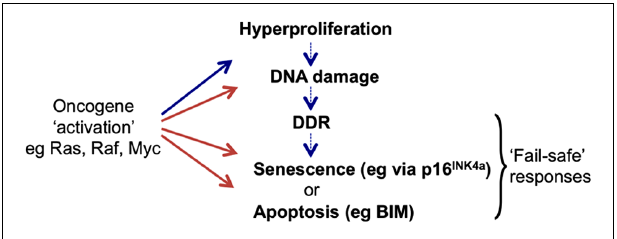
FIGURE 1 |Activation of cell proto-oncogenes can lead to oncogenic stress responses (OSR). Oncogene “activation” by mutation or constitutive expression at supra-physiological levels can induce aberrant cell division that may become manifest as rapid cell proliferation (hyperproliferation). However higher vertebrates have evolved cell intrinsic “fail-safe” responses to recognize such cells and so block their proliferation or eliminate them completely.These can include the induction of tumor suppressors (ts) such as p16 INK4a that halt the cell cycle and can cause cells to enter a prolonged state of arrest called senescence, or pro-apoptotic proteins such as BIM that can induce programmed cell death (apoptosis). Responses may involve direct activation of the ts genes by oncoproteins or they can result from secondary signaling pathways (DDR) linked to the detection of damaged DNA produced during periods of aberrant DNA replication and cell